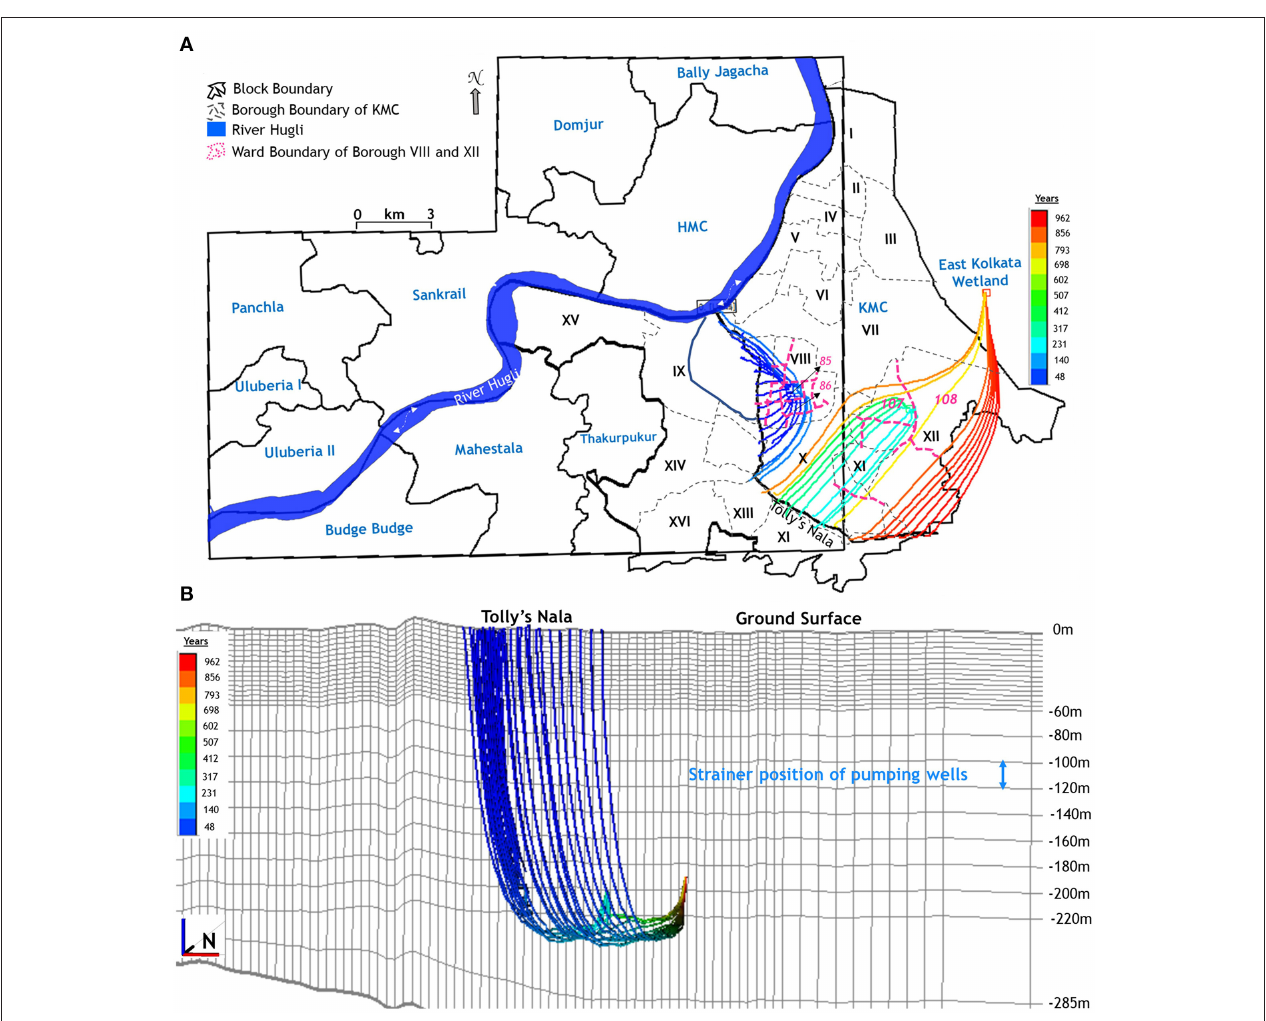
FIGURE 11 | (A) Path lines of forward tracked particle under present development pumping conditions. (B) 3-D view of particle path lines from Tolly’s Nala (recharge area) into the aquifer under present development conditions; vertical exaggeration is 75x.